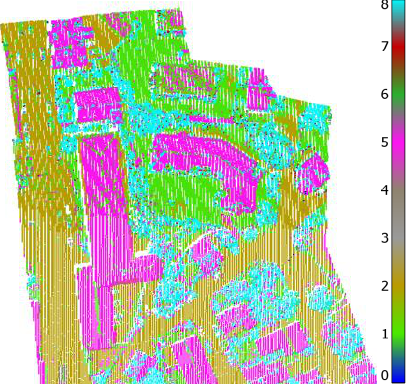
Figure 1. Colour legend for labelled classes in dataset.